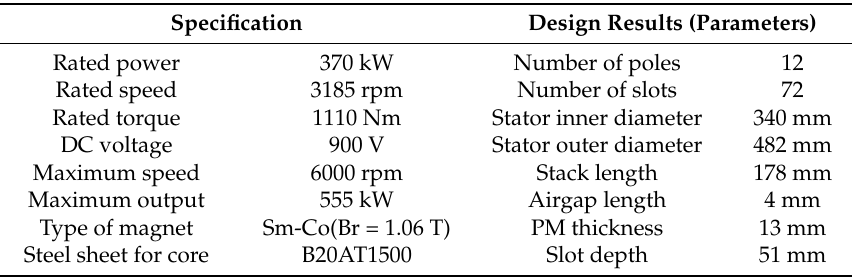
Table 1. SPM motor specification and design